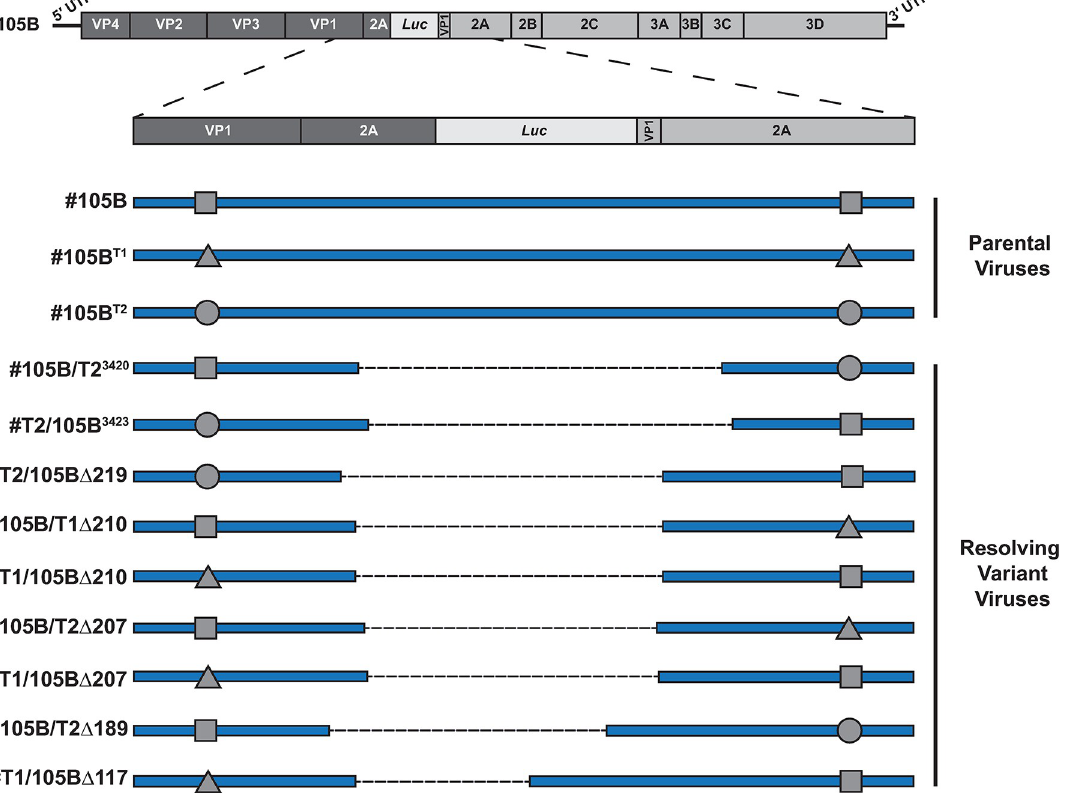
Fig 8. Analysis of barcoded #105B recombinants. Schematic representation of unique recombinant variants identified following co- infection of #105B with barcoded virus #105B T1 or #105B T2 , and passage on HeLa cells until resolution was observed. Sequence names are given on the left with the top three, #105B, #105B T1 and #105B T2 , representing parental constructs with modified sequences flanking the resolution window represented by a triangle (#105B T1 ) or a circle (#105B T2 ). Fully resolved or partially resolved sequences are shown with a dashed line representing the region that has been lost from the parental sequence, with appropriate shapes denoting the parental construct from which the 5 0 and 3 0 sequences were derived.